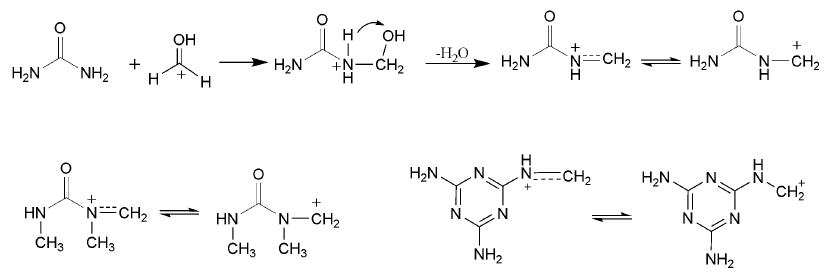
Figure 4. Formation of carbocation intermediates.